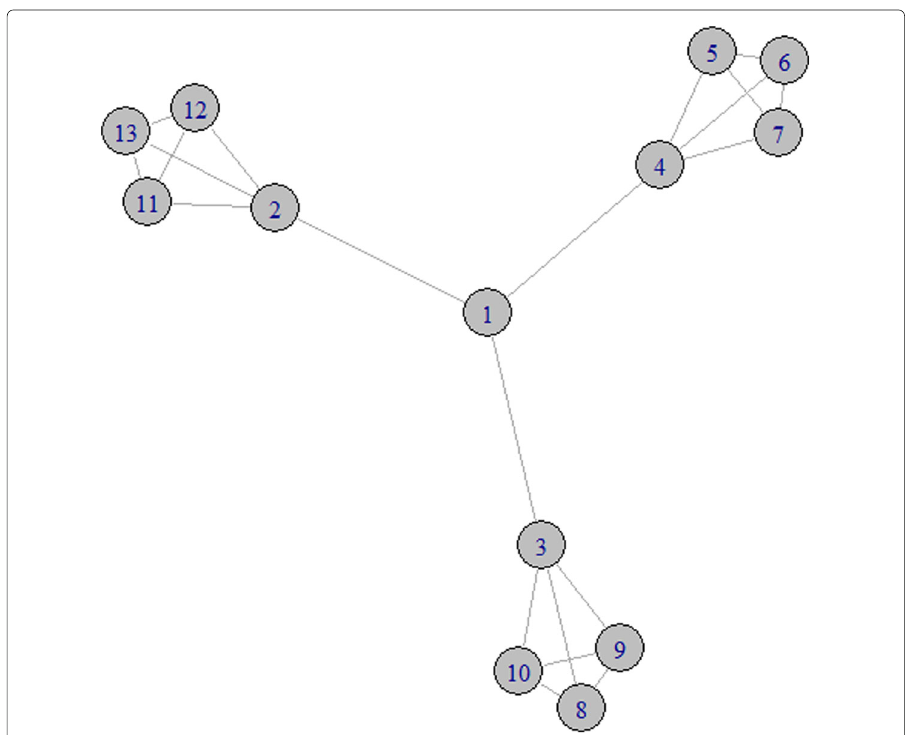
Fig. 2 A network with 13 nodes and three cliques with four nodes